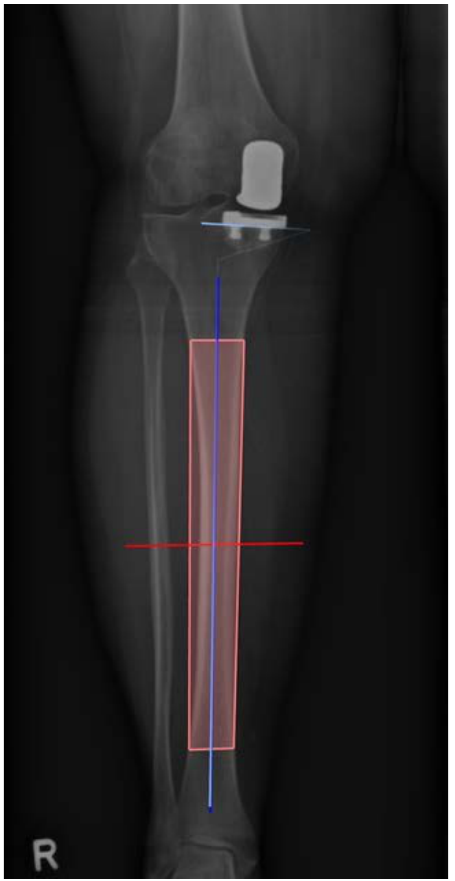
Figure 4. Illustration of the measurement process. Two points on the medial and two on the lateral cortex were marked and thus the longitudinal axis was calculated. Next a tangent was drawn to the lower border of the tibial component and thus the medial inclination calculated between tangent and longitudinal axis. In this case of group 1 the angle was 87.4° varus (R = right side). The posterior inclination of the tibial component was determined from the lateral radiographs according to Faschingbauer et al. [13]. One tangent was applied to the posterior cortex, another to the caudal end of the component. Thus, the angle was calculated between the two lines. This process of measurement is shown in Figure 5.